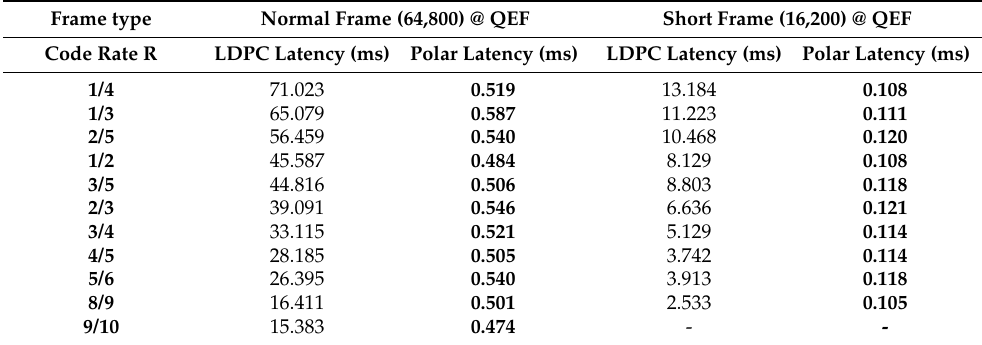
Table 4. Decoding average latency comparisons between LDPC code and optimized Polar code for normal frame and short frame. (bold cells represent the best values).